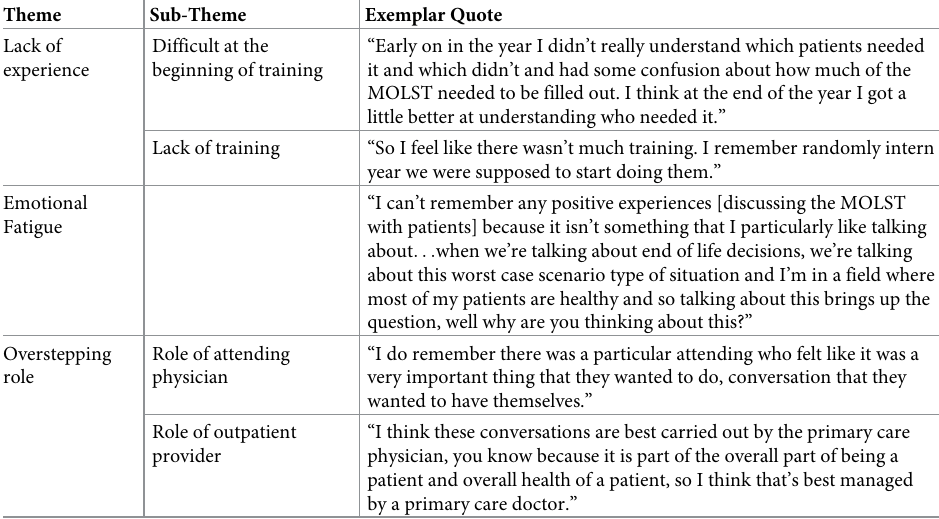
Table 2. Physician barriers to comfort in completion of